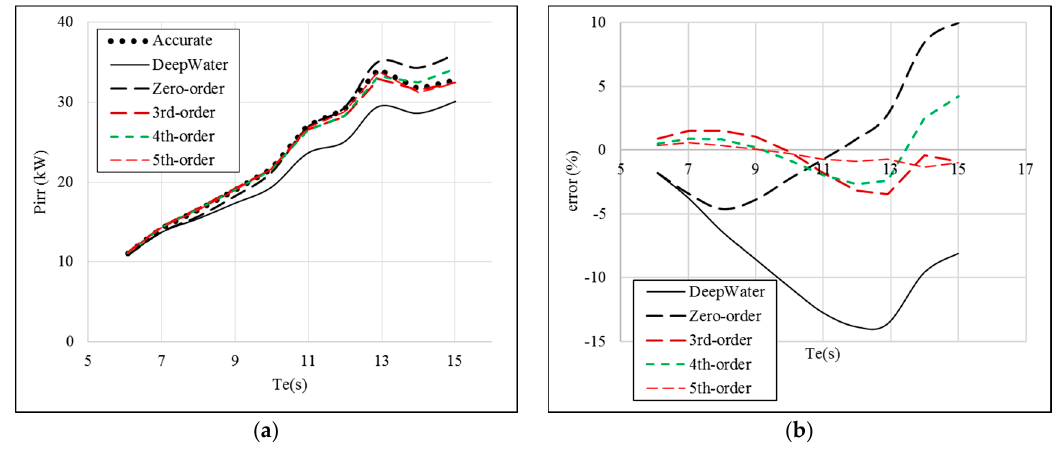
Figure 12. Comparison of the calculated wave power and the corresponding error using different methods for measured waves at AMETS (water depth = 50 m). ( a ) Calculated wave power; ( b ) Error. The 3rd-order, 4th-order and 5th-order approximations all give better wave energy calculations, and for most waves, the maximal errors are smaller than 3%. It is noted that the largest error for the 3rd-order method happens at wave periods between 11 s and 13 s.